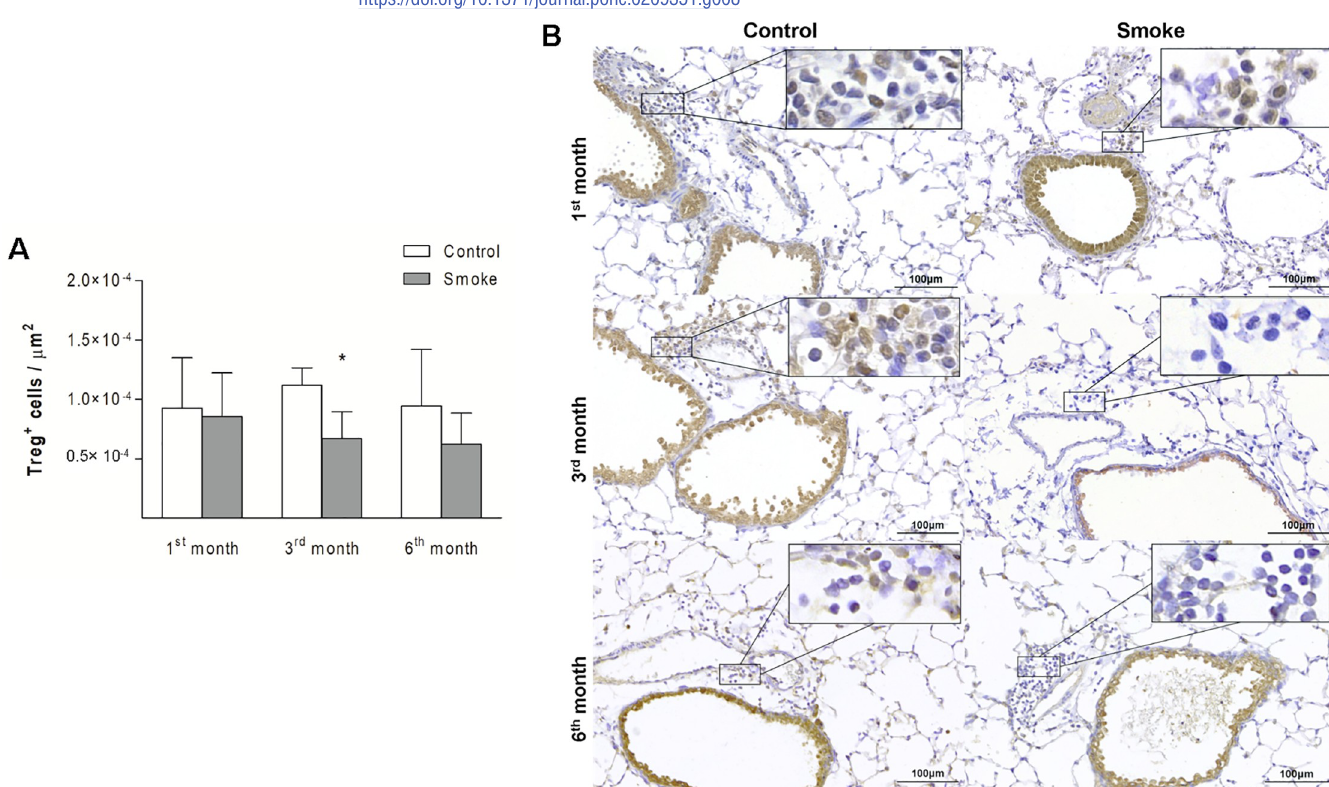
Fig 9. Treg cells in peribronchovascular areas. The numbers of Treg cells in peribronchovascular areas obtained for the Control groups after 1 (n = 8), 3 (n = 6), and 6 (n = 5) months and Smoke groups after 1 (n = 7), 3 (n = 6), and 6 (n = 10) months are presented as the means ± SDs. (A) Significant difference was found after 3 ( � P = 0.0024, t-test) months. (B) Representative photomicrographs of Treg cells in peribronchovascular areas are shown at 200 × magnification, and images at 1000 × magnification are shown in each insert. https://doi.org/10.1371/journal.pone.0209351.g009 PLOS ONE | https://doi.org/10.1371/journal.pone.0209351 January 10,